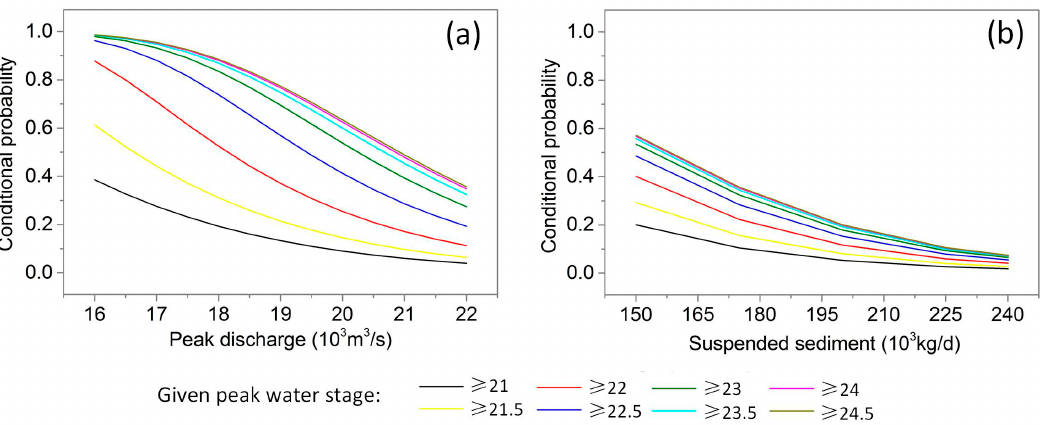
Figure 8. Conditional probability P Q | Z ( a ) and P S | Z ( b ) with various given water stages when main channel elevation and forest coverage rate are assumed to be 6 m and 70%, respectively.